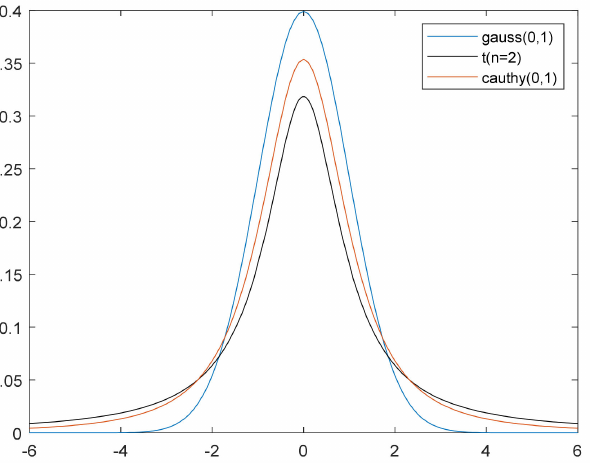
Figure 1. Probability density curves of Cauchy, Gaussian and